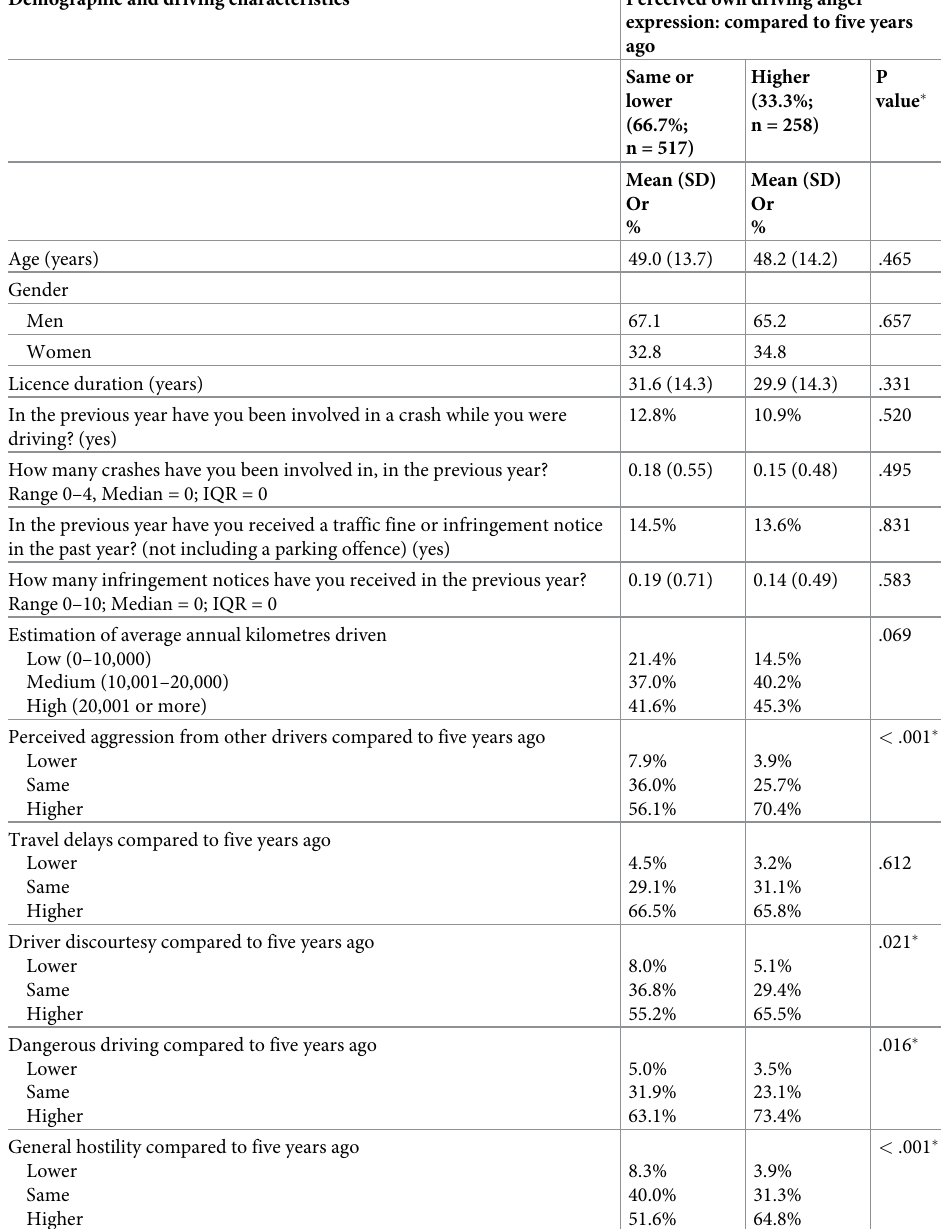
Table 4. Demographic differences between drivers whose aggression had increased, versus those whose aggression is the same or lower (N = 774). Demographic and driving